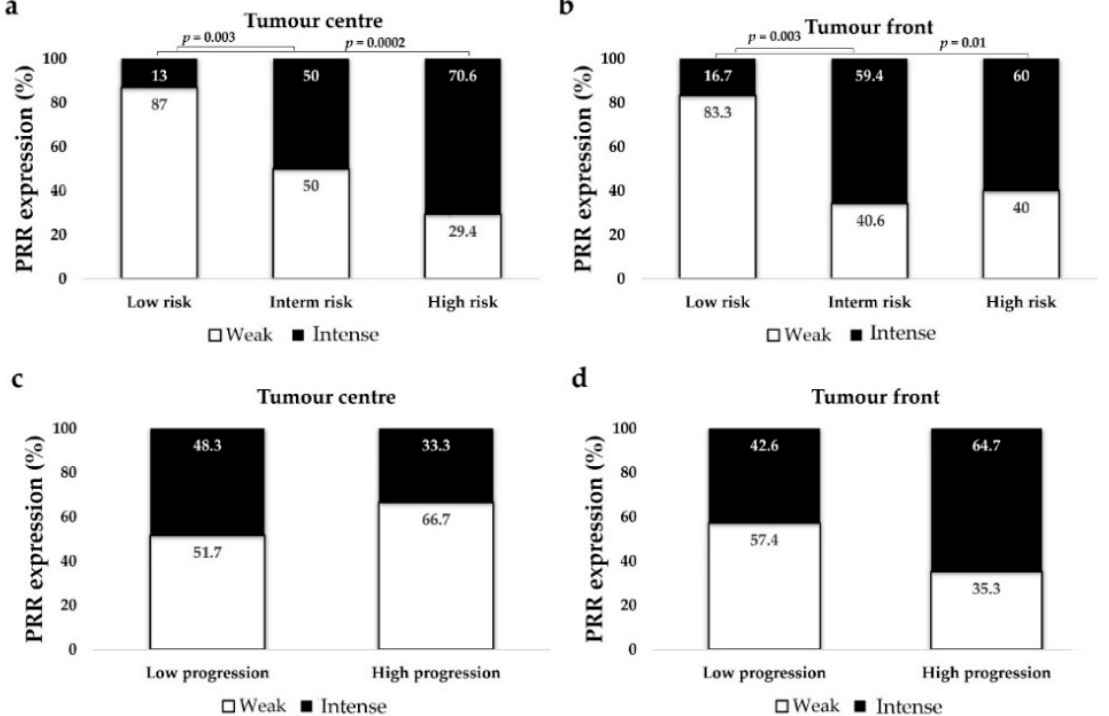
Figure 5. Immunohistochemical PRR staining according to UISS (mortality risk) ( a , b ) and SSIGN (disease progression) scales ( c , d ). PRR staining intensity was grouped as weak and intense. Chi-square test was used for data analysis.